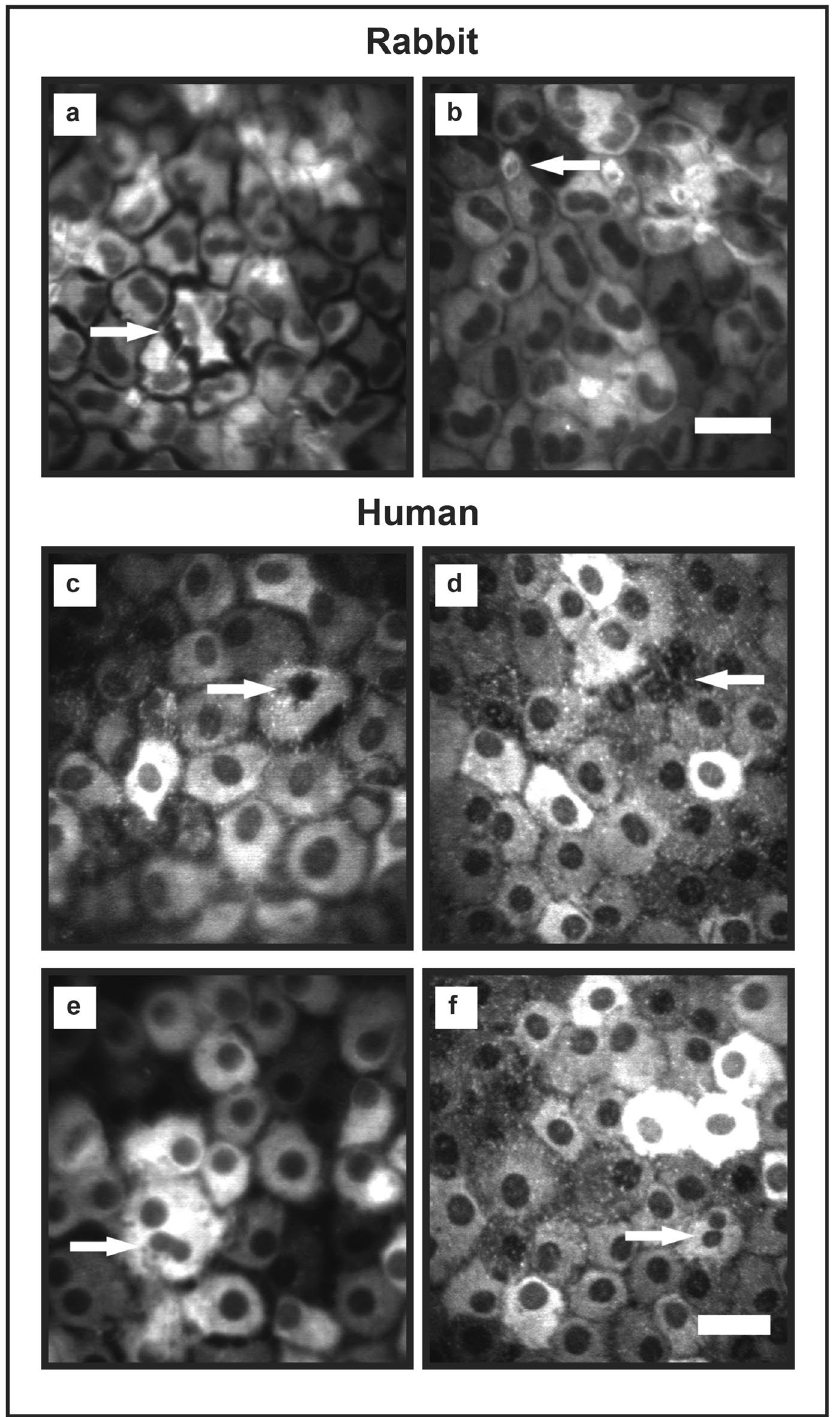
Figure 11. High-resolution images achieved with Spectralis and Rostock module. High-resolution images of rabbit endothelial cells (stained with DIR by intracameral injection) and human endothelial cells (from EK transplants stained with DIR) are achievable with the HRA/Spectralis and Rostock module. ( a ) A rabbit endothelial cell can be seen detaching from the monolayer. ( b ) Small, possibly inflammatory, cells staining positive for DIR are visible interspersed with the rabbit endothelial cells. ( c ) A human endothelial cell undergoing apoptosis exhibits a pyknotic nucleus and separation from adjacent cells. ( d ) Podocyte extension to fill a gap in the monolayer following cell loss can be seen. ( e ) Bi-lobulated nuclei and ( f ) smaller adjacent nuclei suggestive of paired daughter cells are suggestive of in vivo cell division. Scale bar, 50